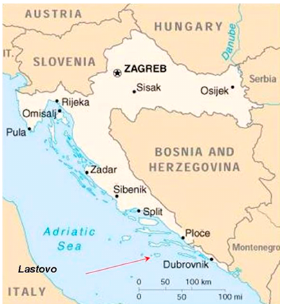
Figure 1. Location of the Lastovo archipelago nature park (Croatia) (source: [27]).